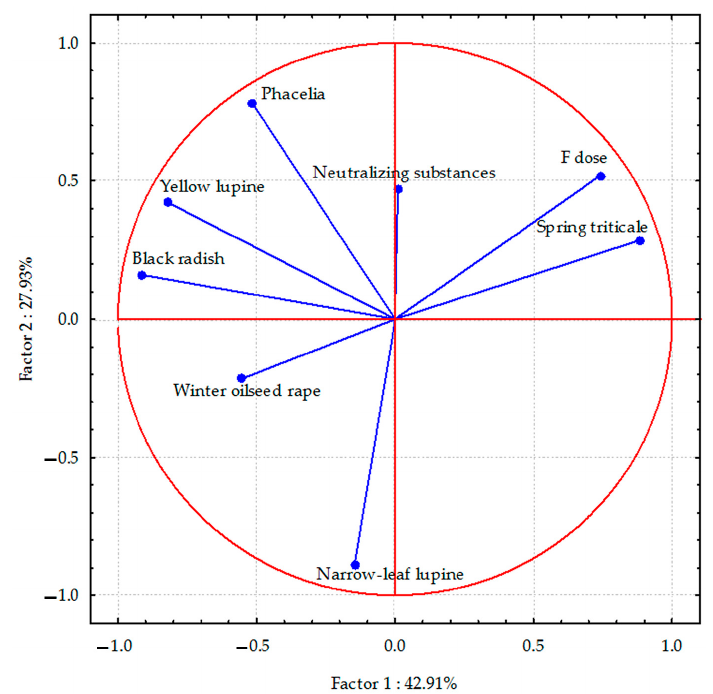
Figure 1. Sodium content in aerial parts of plant species calculated with PCA method. Vectors represent sodium content in aerial parts of plant species versus fluorine dose and neutralizing substances application.